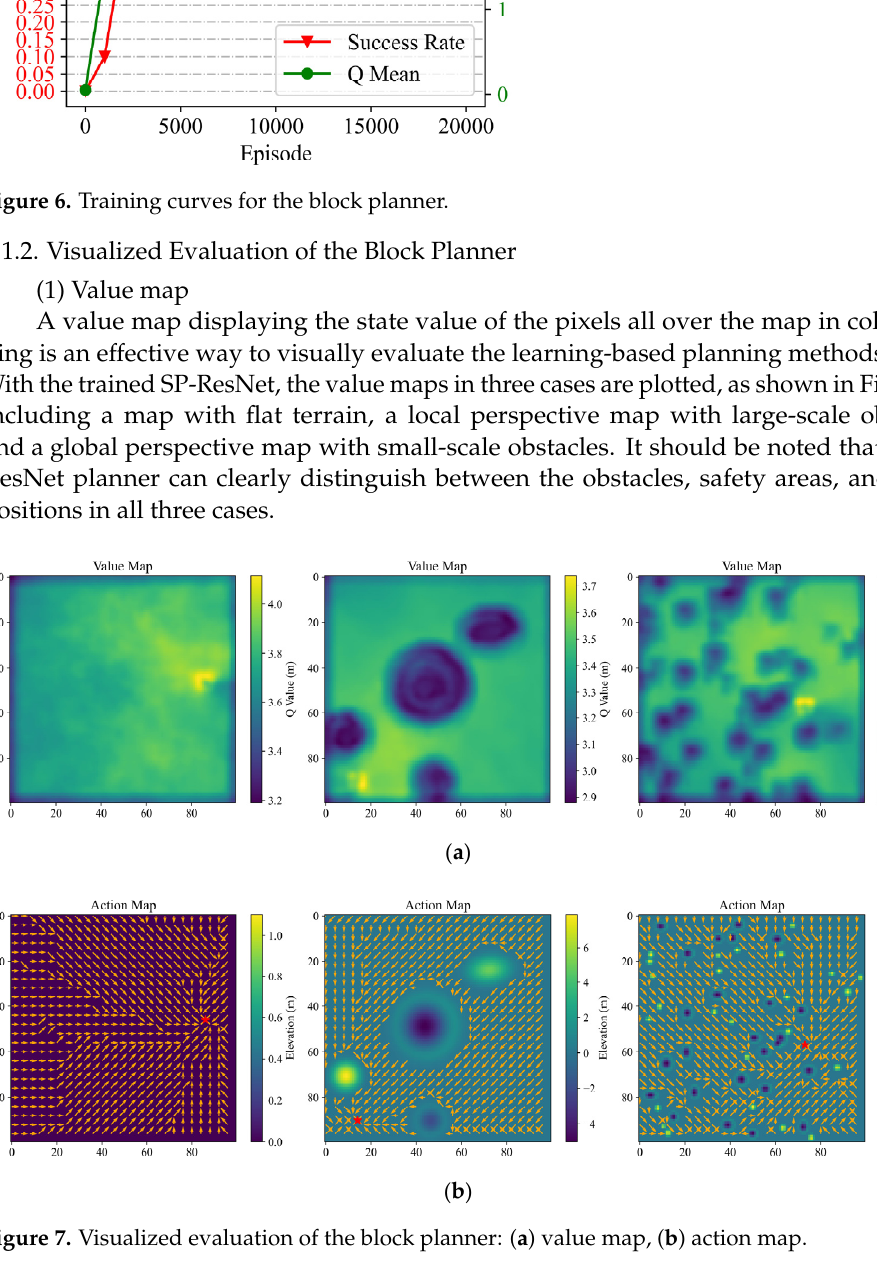
Figure 6. Training curves for the block planner.